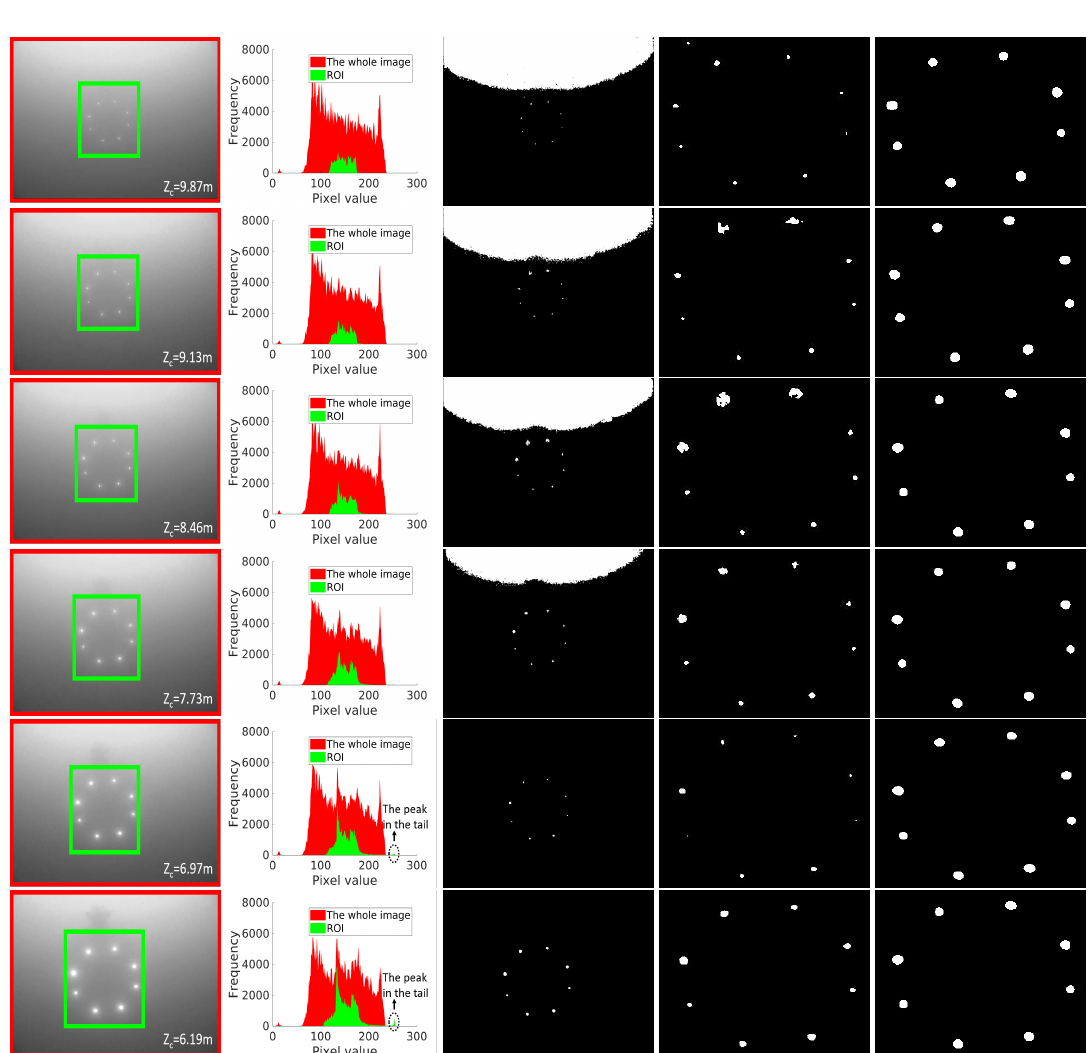
Figure 7. (First column) Distance-ordered landmark images captured in a run of underwater recycling. The distance between camera and docking station in the z c direction is shown in the lower right corner of each image. The green rectangle indicates the region of interest (ROI) predicted by the coarse detection phase. (Second column) Histograms of the whole image and ROI. The histogram in red corresponds to the whole image, indicated by the red rectangle. The histogram in green corresponds to the ROI, indicated by the green rectangle. (Third and fourth column) Detection results from applying HATS to the whole image (third column) and ROI (fourth column). HATS is only effective and used in the case where a peak exists in the tail (Rows 5 and 6). For cases in which a peak does not exist in the tail, a fixed threshold is used for segmentation. The fixed threshold was set to 180 in Rows 1–4. (Fifth column) Detection results of our proposed method ( σ =